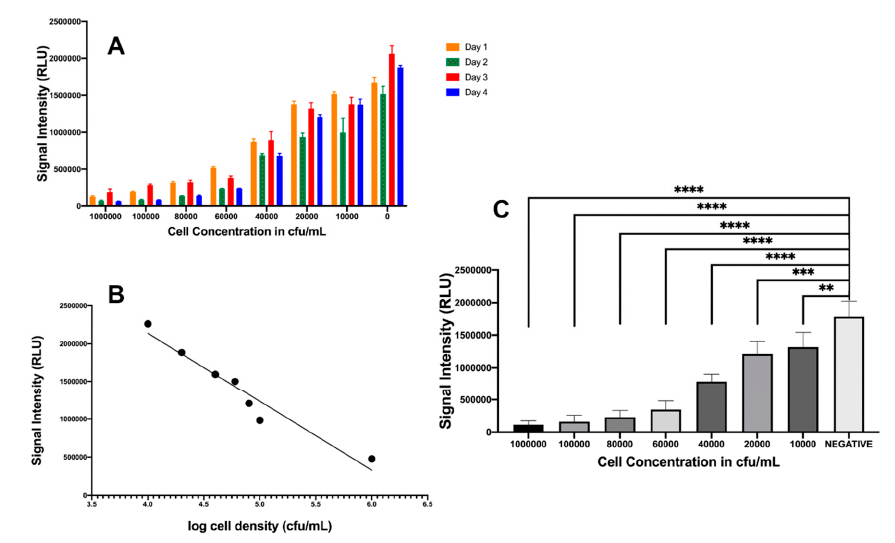
Figure 4. Relationship of signal intensity from P. leiognathi with various cell concentrations of E. coli . ( A ) UTI assay for 4 consecutive days. ( B ) Bioluminescence assay for detecting E. coli at various concentrations. A linear relationship between log cell density and bioluminescent signal. ( C ) ANOVA of UTI assay. A decrease in luminescence was measured after 5 min incubation at room temperature. ** p = 0.0023, *** p = 0.0002, **** p ≤ 0.0001. Statistical data analysis was performed using GraphPad Prism version 8.3.4 for Mac OS, GraphPad Software, San Diego, CA,